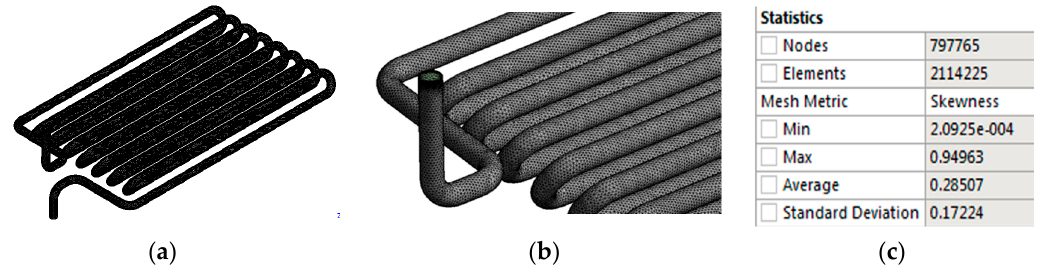
Figure 4. ( a ) Mesh Created; ( b ) Zoomed View; ( c ) Geometry Statistics.